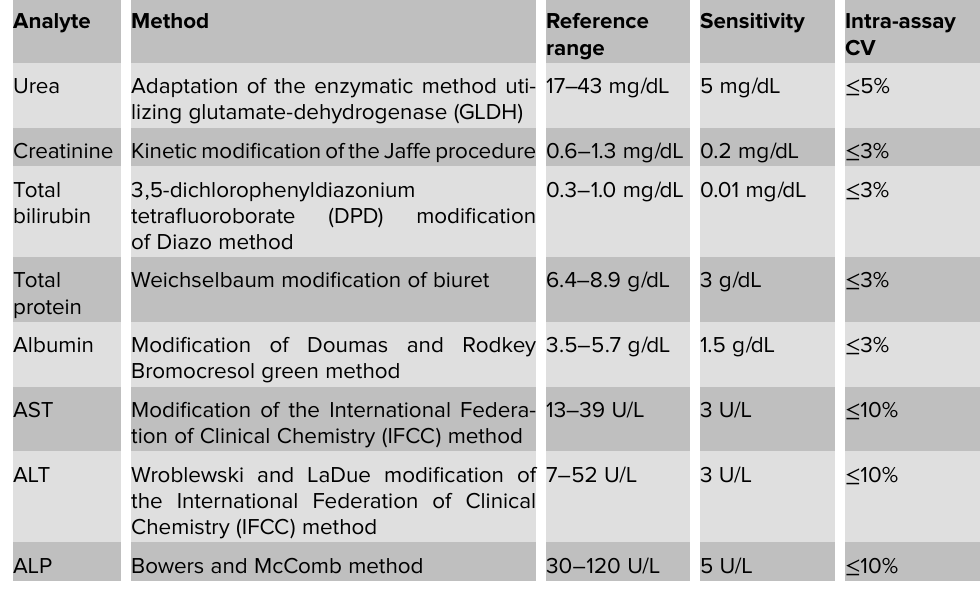
Table 1: Assay specifications of hepatic and renal